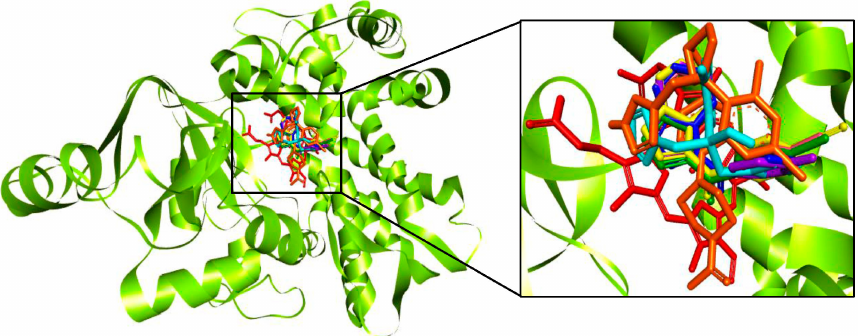
Figure 2. Binding mode on CYP51 Ca of the 3-benzoyl imidazo[1,2- a ]pyrimidines and reference compounds. The five selected compounds and the reference compounds were overlaid on this receptor. CYP51 Ca is shown as a flat ribbon, while the compounds are illustrated with a stick model. Accordingly, the heme group is depicted in red, fluconazole in cyan blue, the ketoconazole in orange, 4a in dark blue, 4d in pink, 4f in yellow, 4i in green, and 4j in purple.